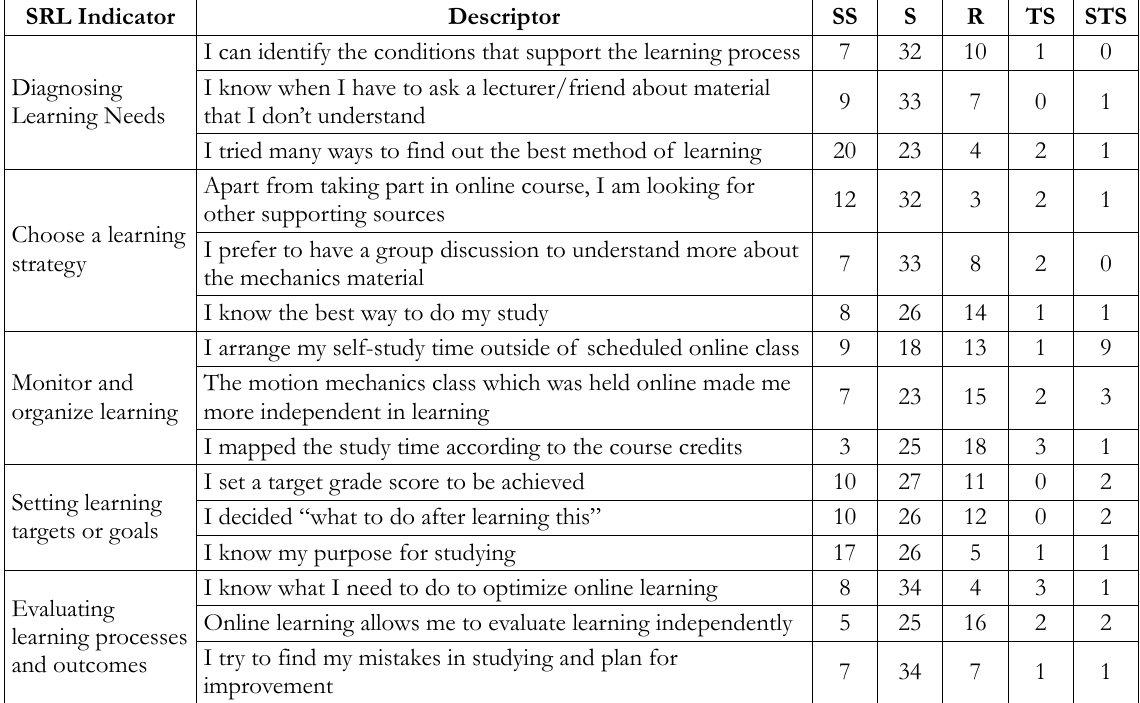
Table 1. Results of Student SRL Questionnaire Answers on Online Basic Physics